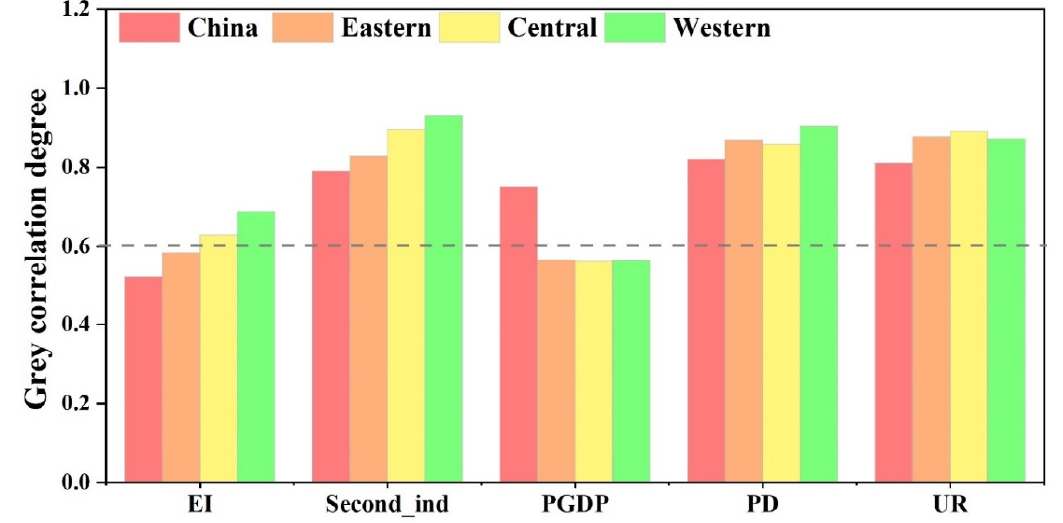
Figure 6. The grey correlation degree between different impact factors and anthropogenic PM 2.5 concentrations in eastern, central, and western China.